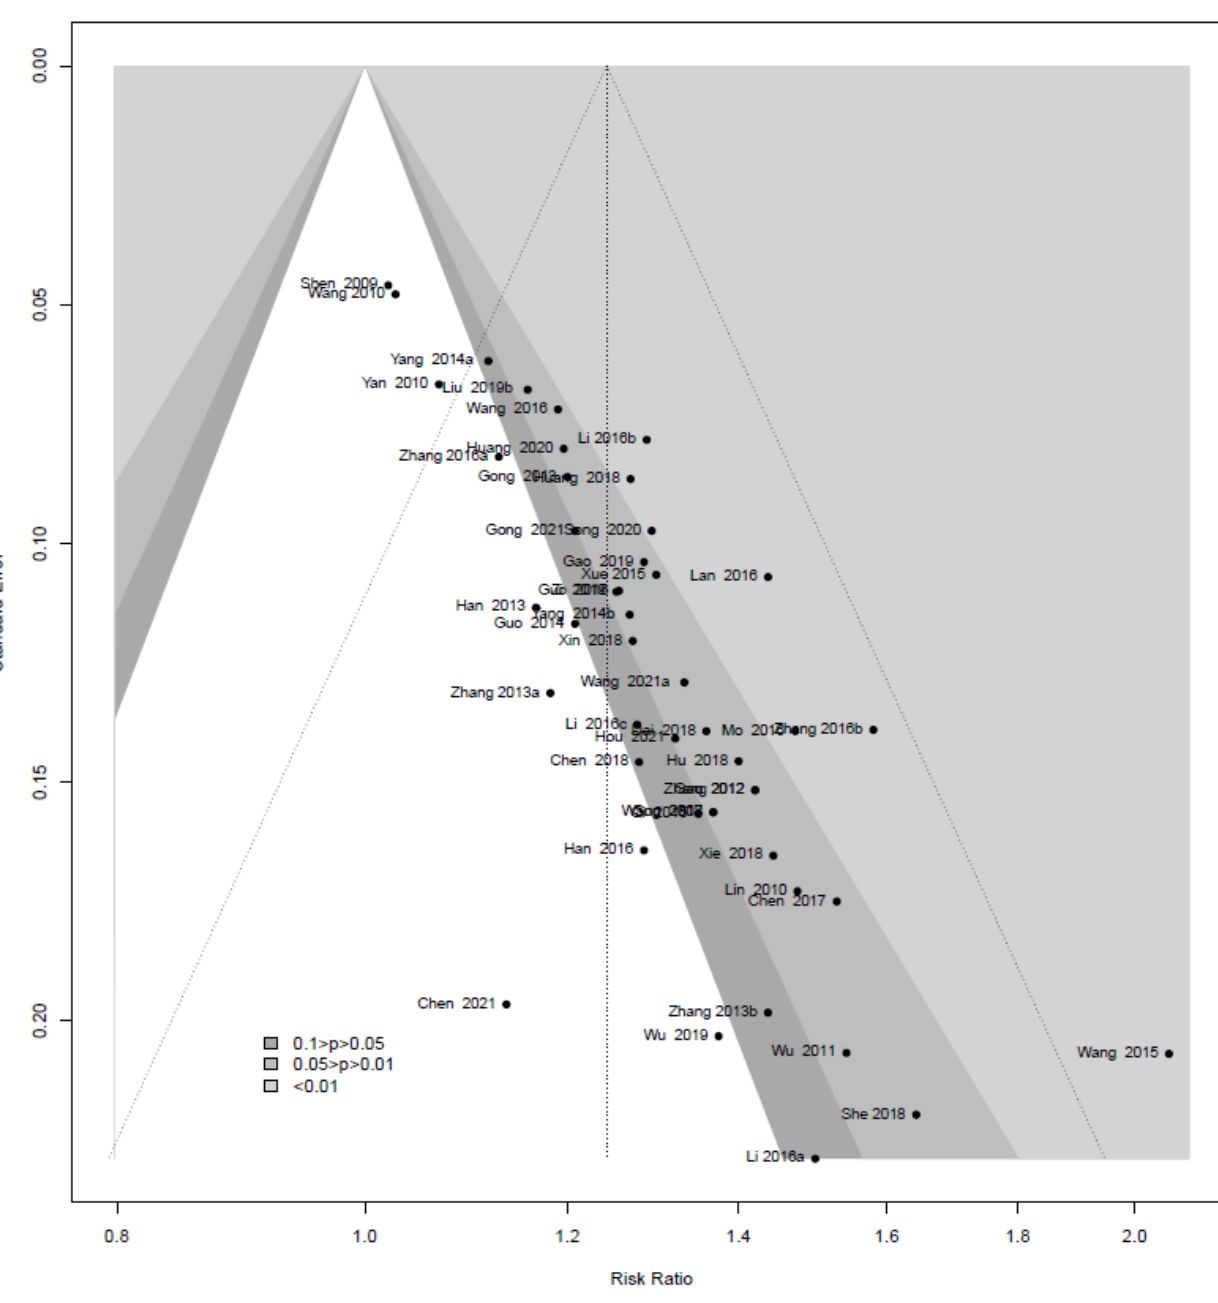
Figure 17. Contour-enhanced funnel plot for the meta-analysis of East Asian herbal medicine prescribed for peripheral neuropathy.